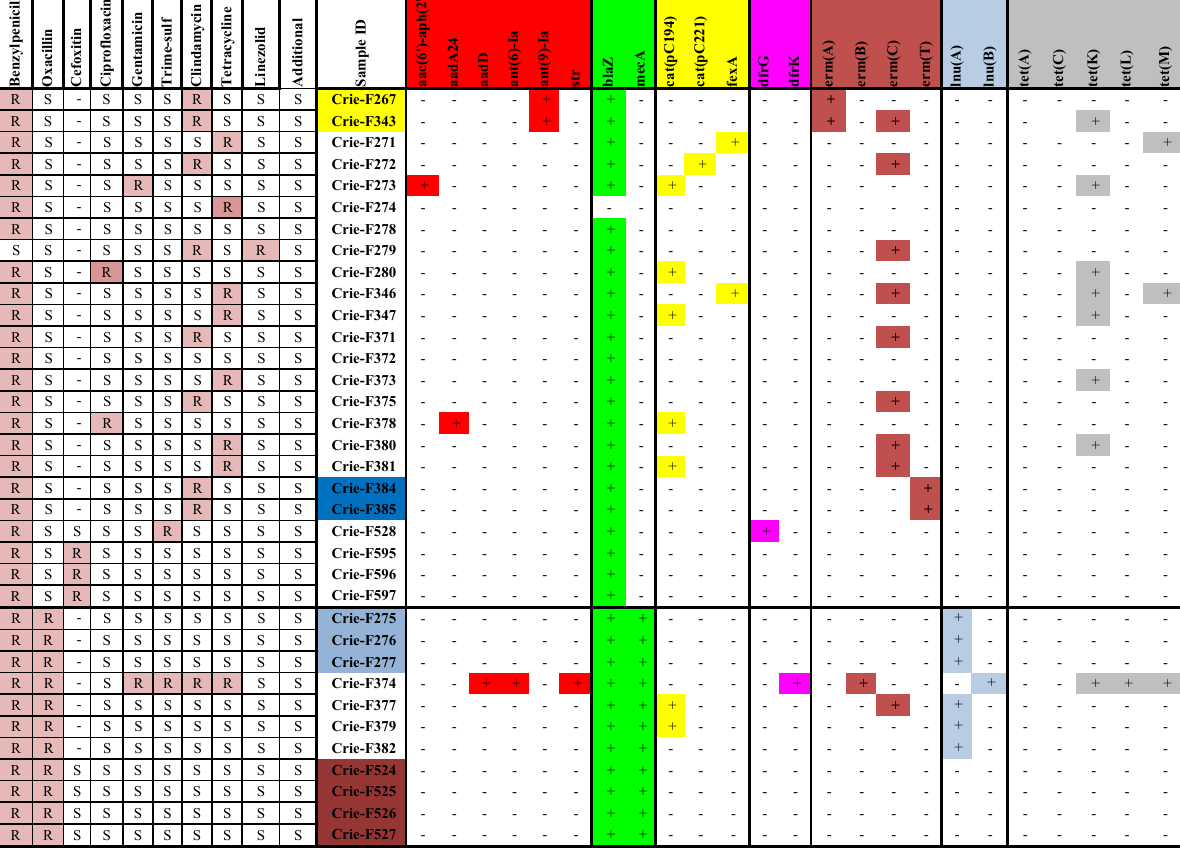
Figure 2. Phenotypic and genomic antimicrobial resistance profiles of S. aureus isolates from ready-to- eat food. ‘Trime-sulf’ represents trimethoprim-sulfamethoxazole. ‘Additional’ antibiotics, to which all isolates were susceptible, include fosfomycin, fusidic acid, and tigecycline. Antibiotics belonging to the same group are colored with the same color. ‘+’ means that the gene is present in the isolate, ‘-‘ – that the gene was not found. ‘R’ means that a given isolate was resistant to particular antibiotic, ‘S’ – that an isolate was susceptible to this drug. The isolates found to belong to the same strain are highlighted with